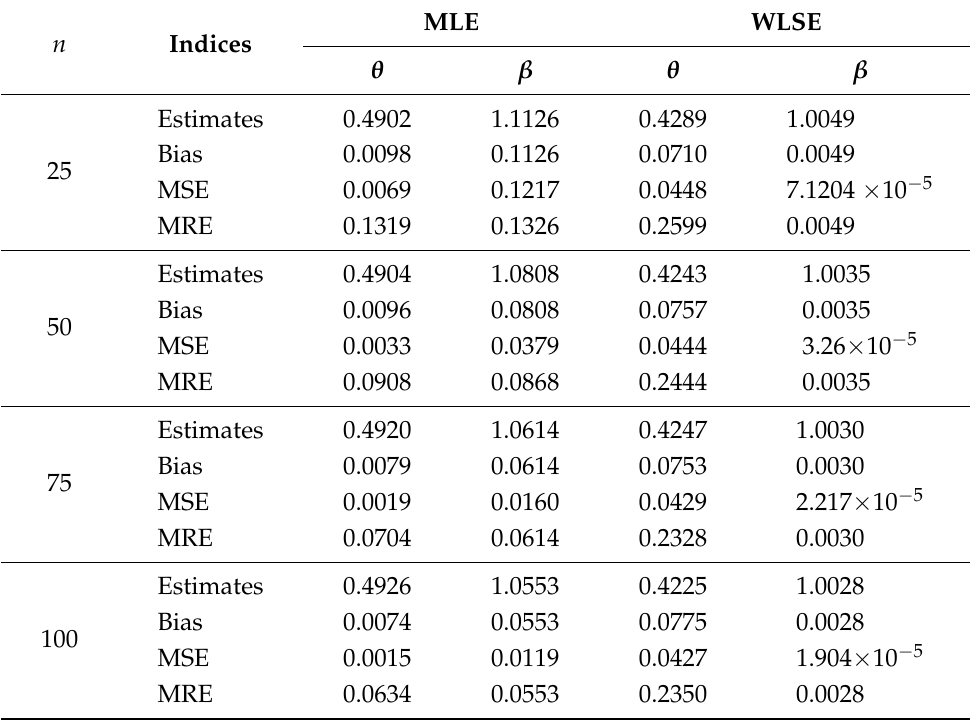
Table 6. Simulation results of our estimation approaches for the DPsL distribution with θ = 0.5, β = 1.